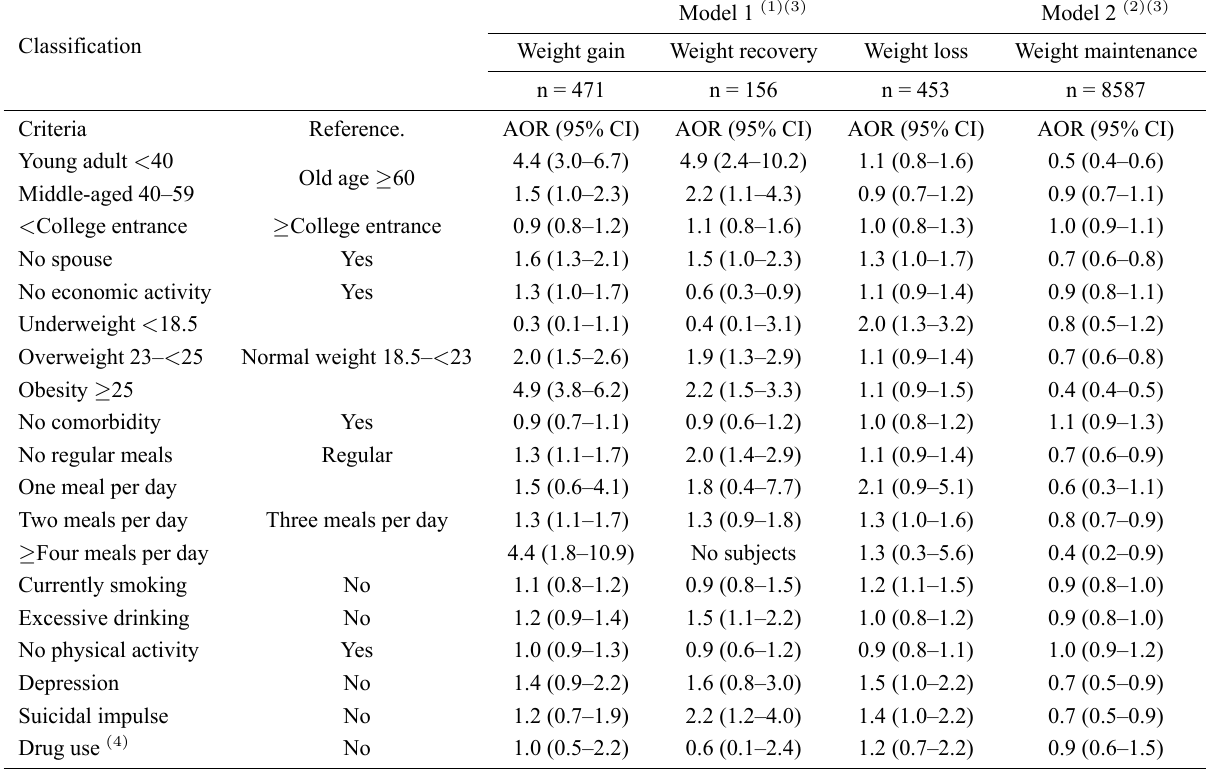
Table 4. The adjusted odd ratios of weight change and maintenance by male subject’s